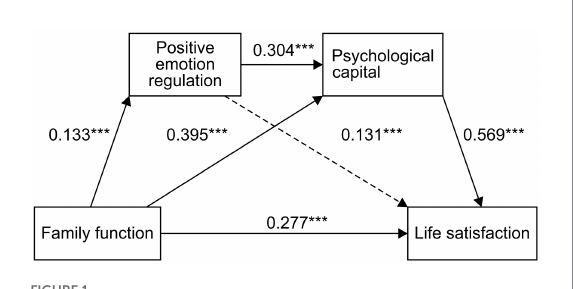
FIGURE 1 Chain mediation model of family functioning, PsyCap, positive emotion regulation strategy, and life satisfaction. *** is the marked path